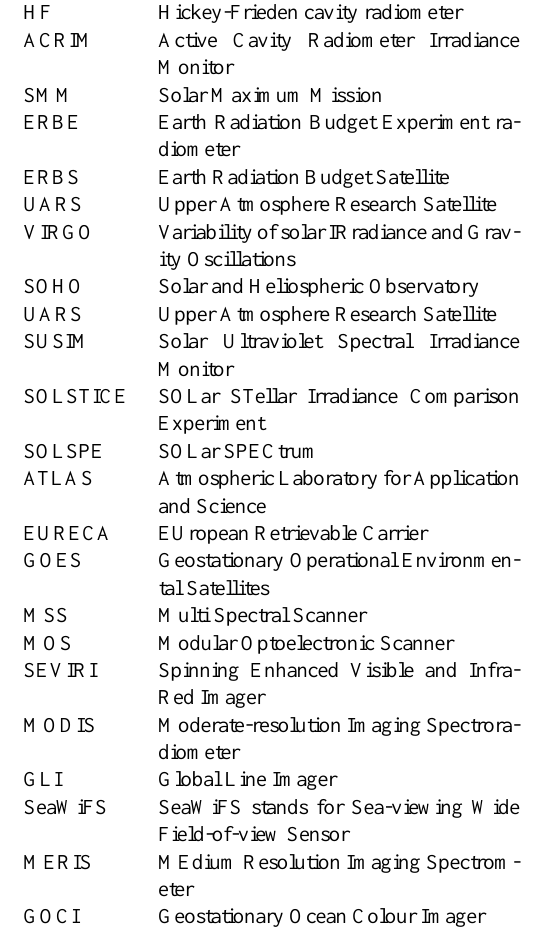
Table 2. Glossary of